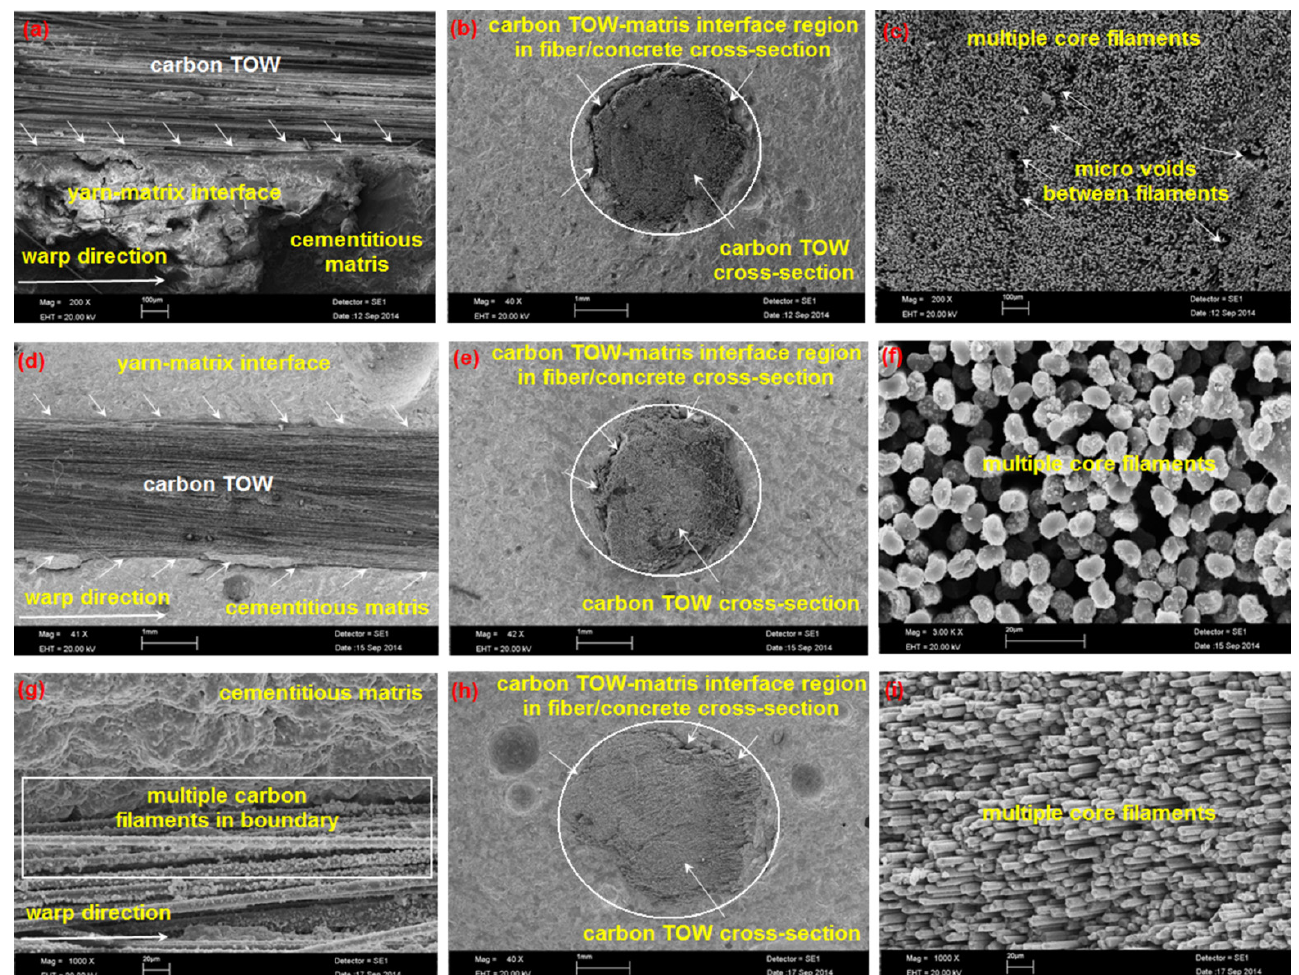
Figure 5. SEM graph of some multiaxis 3D carbon fiber concrete before the flexural test. ( a ) C-1D structure in carbon fiber length; ( b ) C-1D structure in filament bundle cross-section; ( c ) carbon filament bundle core of C-1D; ( d ) C-2D structure in filling carbon fiber length; ( e ) C-2D structure in filling carbon TOW cross-section; ( f ) close SEM images of the filament bundle core of C-2D; ( g ) C-4D structure in filling carbon fiber length; ( h ) C-4D structure in filling filament bundle cross-section; ( i ) close views of filament TOW core of C-4D.